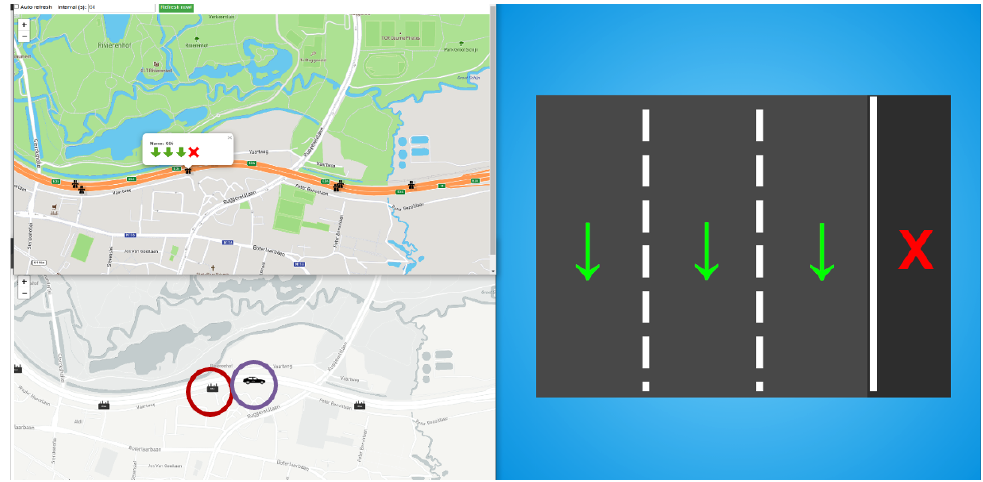
Figure 3. Information presented on the Human-Machine Interface (HMI) when the vehicle is in the Infrastructure to Vehicle Information (IVI) relevance